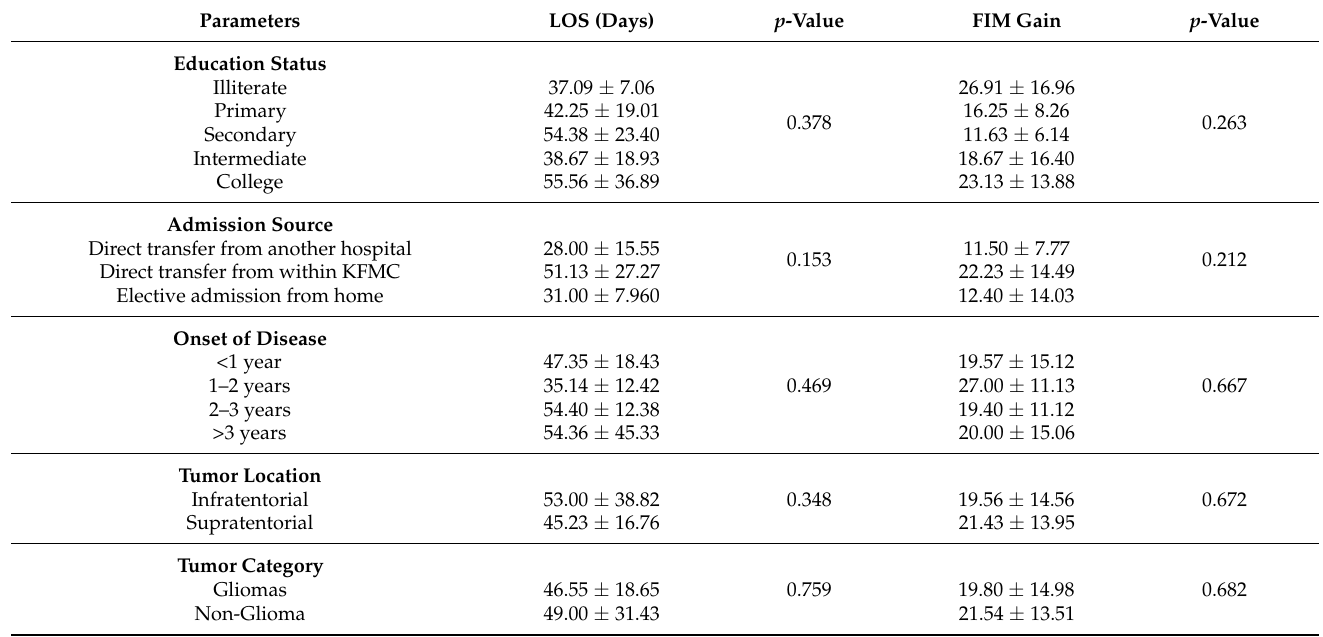
Table 3. Comparison of LOS and FIM gain with different study